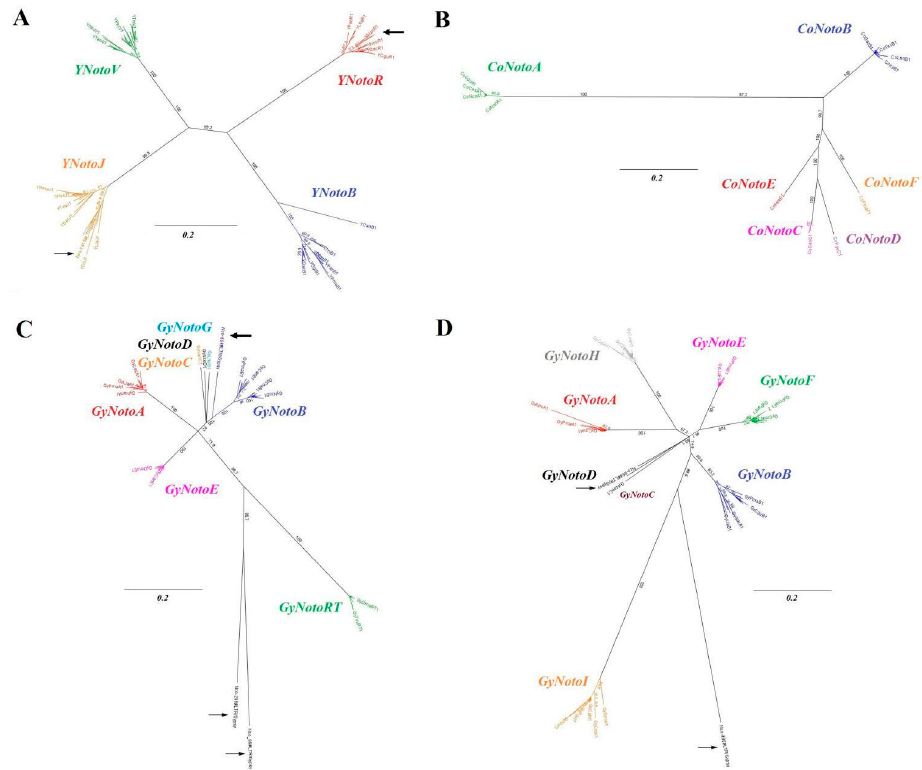
Figure 2. Neighbor joining (NJ) unrooted trees for ( A ) YNoto , ( B ) CoNoto , ( C ) GyNoto (RT/RH) and ( D ) GyNoto (Int) nucleotide sequences for the whole nototheniid transposable element (TE) datasets. Alignements used to construct these trees are presented in Figure S1. Analyses were run using the Jukes–Cantor model and no outgroup. Support for individual clusters was evaluated using non-parametric bootstrapping with 1000 replicates. Arrows show the additional DIRS1 and Gypsy sequences originating from the N. coriiceps genome sequencing [67].